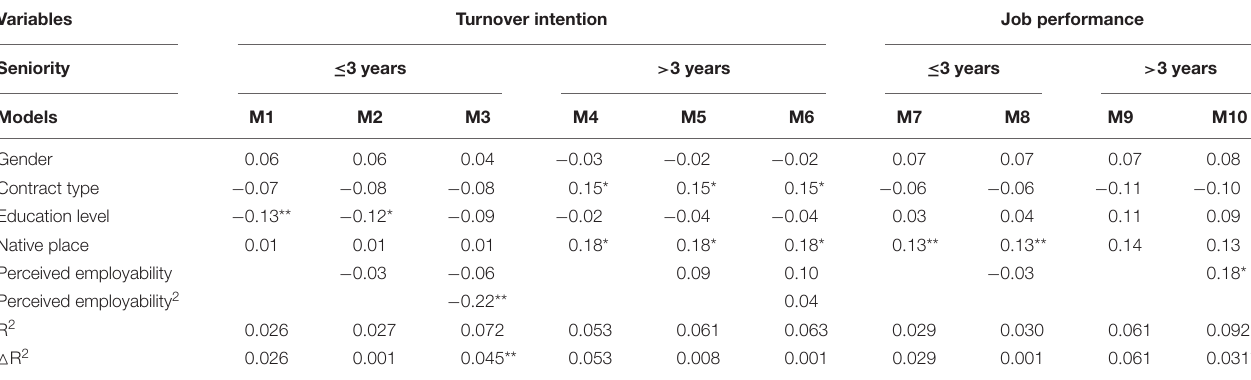
TABLE 3 | Effects of work seniority on perceived employability-turnover intention and perceived employability-job performance relationship.